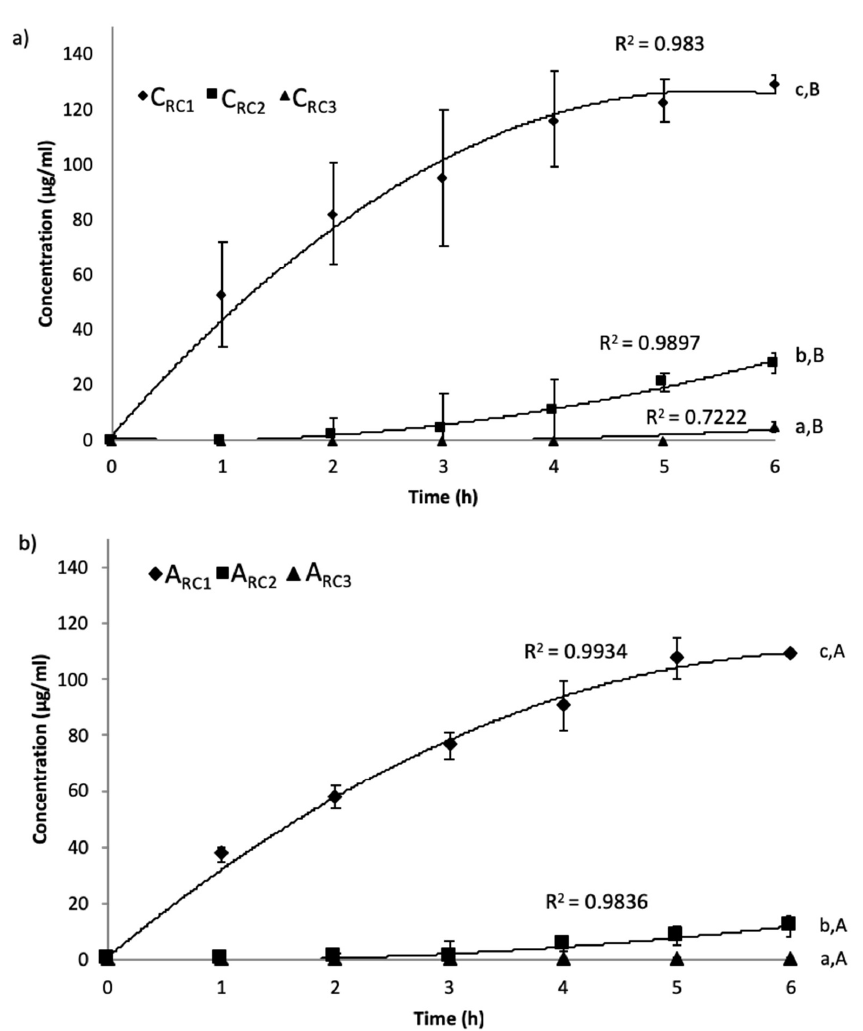
Figure 1. Evolution of peptide concentration in ( a ) cationic (Cationic Recovered Compartment 1, Cationic Recovered Compartment 2, Cationic Recovered Compartment 3, respectively, C RC1, C RC2 , and C RC3 ) and ( b ) anionic (Anionic Recovered Compartment 1, Anionic Recovered Compartment 2, and Anionic Recovered Compartment 3, respectively A RC1 , A RC2 , and A RC3 ) compartments during 6 h of the electrodialysis with ultrafiltration membrane (EDUF) process. Lowercase letters are used to compare the three recovered compartments of the same configuration where capital letters are used to compare the recovered compartments between anionic and cationic configurations. Values followed by different letters were statistically different.